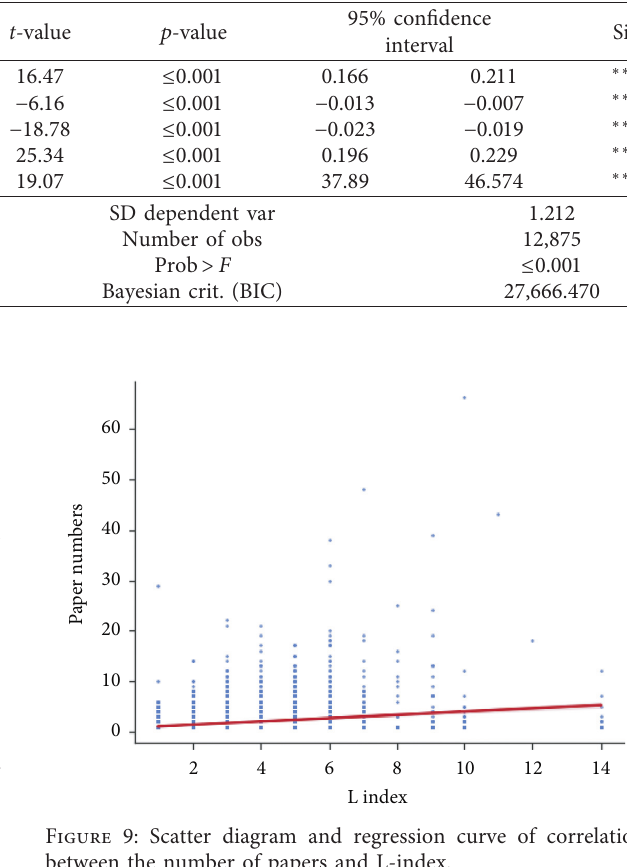
Figure 8: Scatter diagram and regression curve of correlation between H-index and degree centrality. Table 4: Unary linear regression results of H-index and degree centrality.